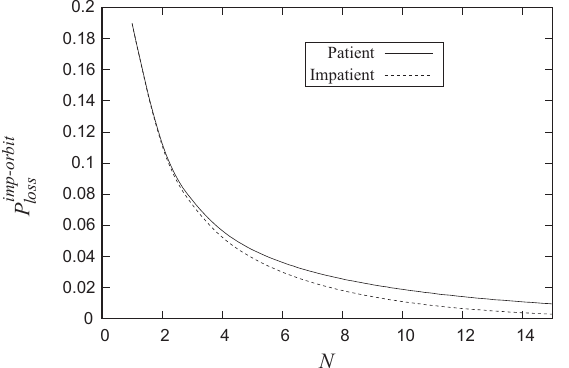
− orbit on the number N loss